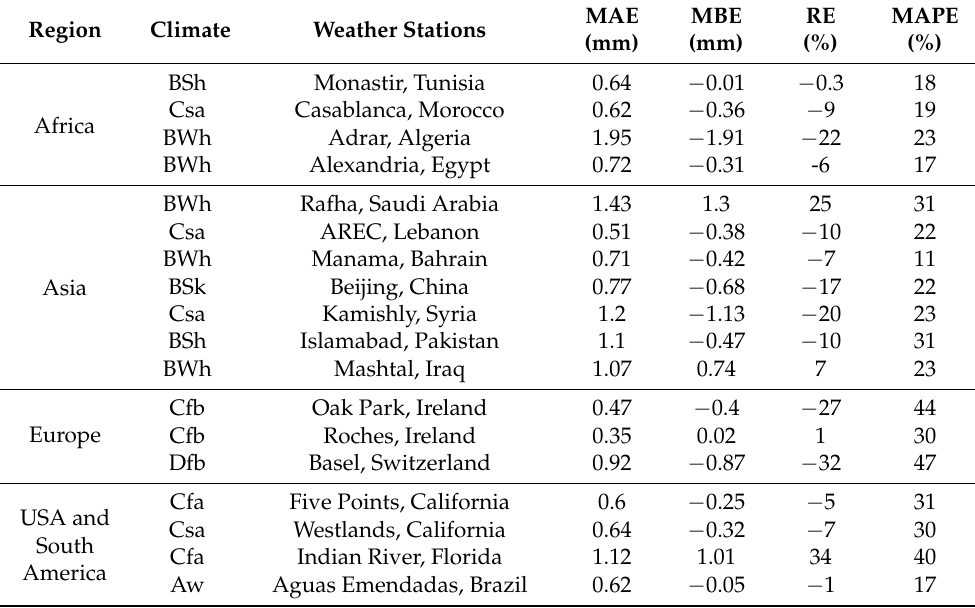
Table A2. Comparison between modeled and weather station ETref for the different studied weather stations grouped by region and climate